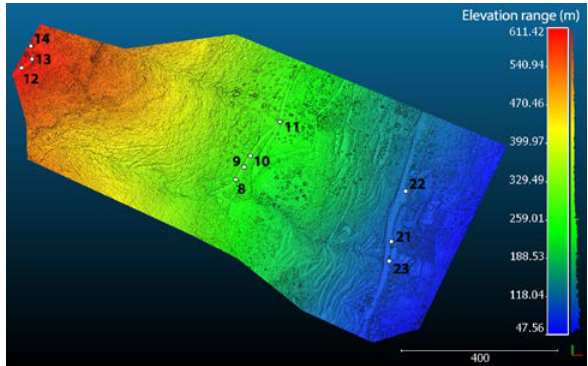
Figure 6. Ground Control Points distribution (units in m)